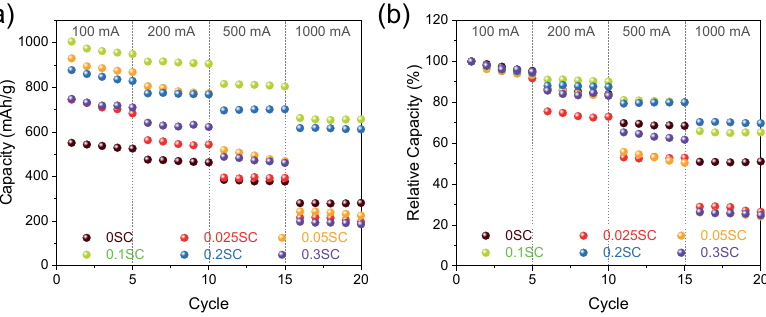
Figure 5. ( a ) Rate performance at a current density ranging from 100 mA/g to 1000 mA/g of SnO 2 @CNTF and ( b ) relative values of the capacity.